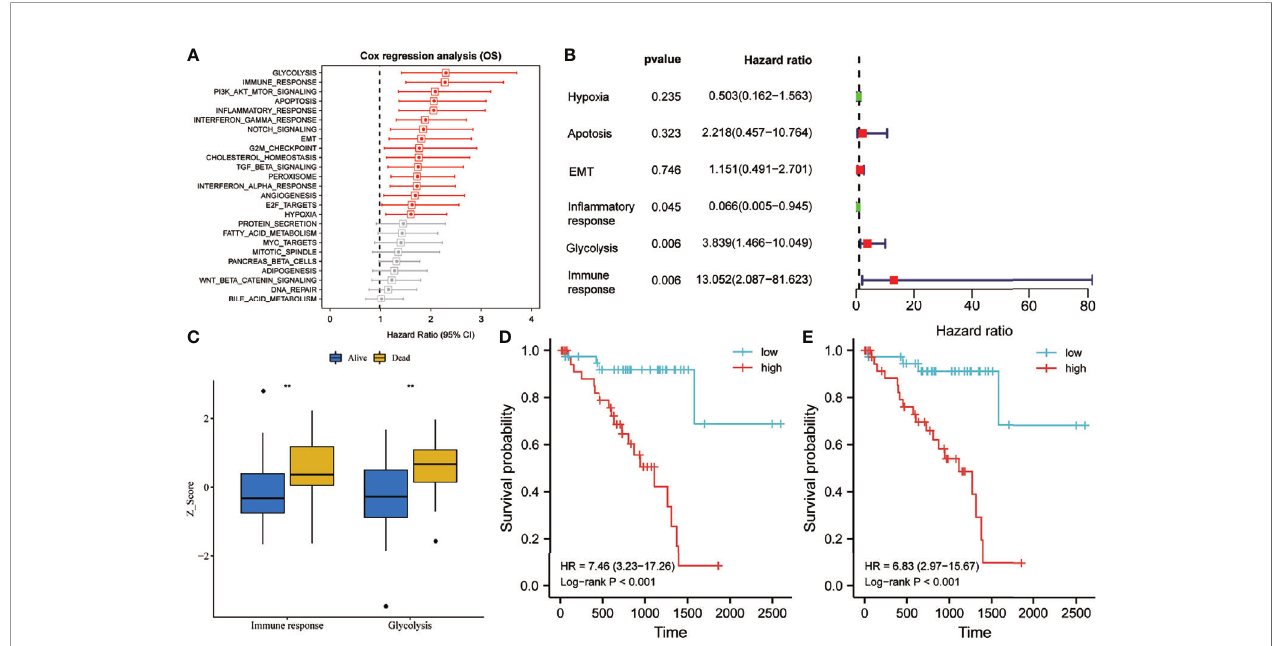
FIGURE 2 | Glycolysis and immune response are identi fi ed as the primary risk factors for survival in uveal melanoma (UM) patients. (A) Univariate Cox regression analysis showed that glycolysis and immune response were the main hallmarks of cancer that affect the overall survival (OS) of UM patients. (B) Multivariate Cox regression analysis showed that glycolysis and immune response were independent risk factors that affect the OS of UM patients. (C) The glycolysis and immune response Z -scores of patients who died during follow-up were signi fi cantly higher than those of patients who are still alive. (D, E) Kaplan – Meier analysis suggested that patients with higher glycolysis and immune response Z -scores exhibited poorer OS. EMT , epithelial – mesenchymal transition; Pl3/Akt/mTOR , phosphatidylinositol – 3- kinase-Akt – mammalian target of rapamycin; TGF , transforming growth factor. **p <